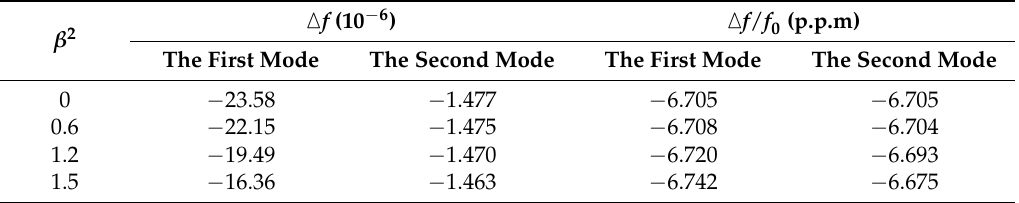
Table 3. The frequency shift of the first and second modes when the particle is located at the tip for different nondimensional